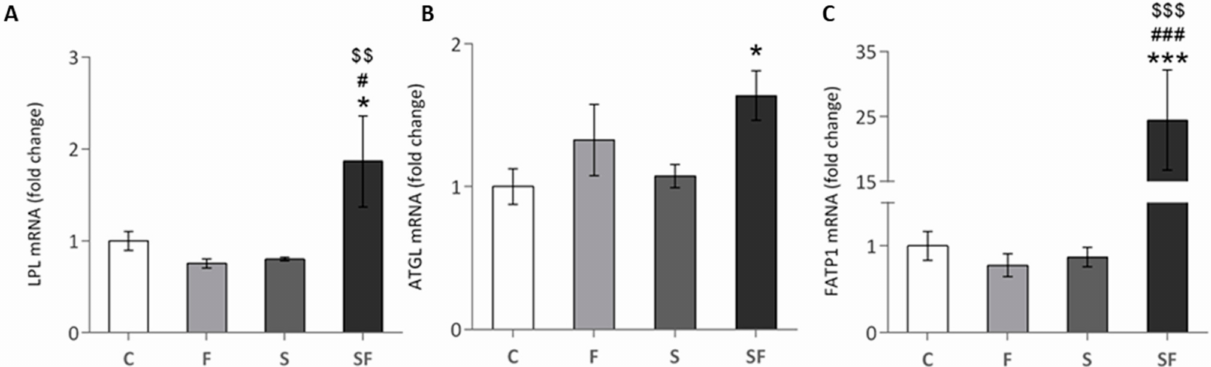
Figure 1. Level of LPL ( A ), ATGL ( B ) and FATP1 ( C ) in skeletal muscle of control (C), fructose (F), stress (S), and stress + fructose (SF). LPL, ATGL and FATP1 mRNA levels compared to HPRT mRNA were determined by TaqMan (LPL and ATGL) and SYBR ® Green (FATP1) real-time PCR in the skeletal muscle. The values represent the mean ± SEM ( n = 8–9 animals per group). All measurements were done in triplicate. Significant between-group differences from post hoc Tukey test are given as follows: * p < 0.05 and *** p < 0.001, SF vs. C; # p < 0.05 and ### p < 0.001, SF vs. F; $$ p < 0.01 and